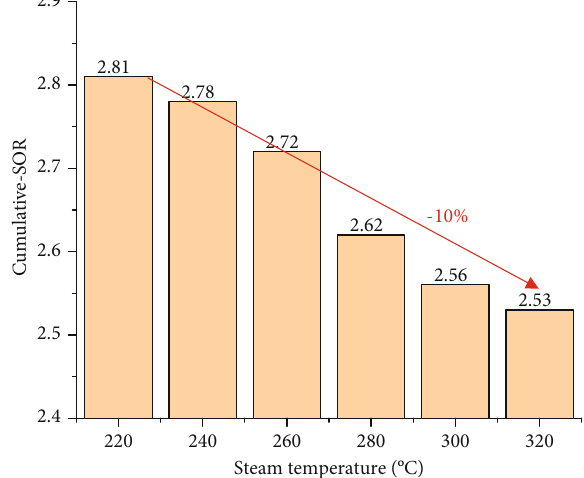
Figure 21: Cumulative SOR at di ff erent steam